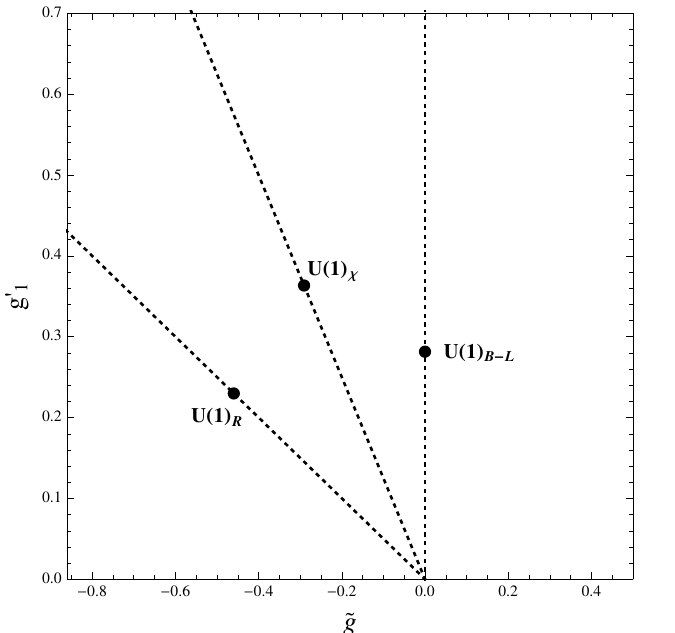
Figure 1. Three typical U(1) ′ charge assignments identified by the dashed lines in the ˜ g The dots represent particular benchmark models described in the